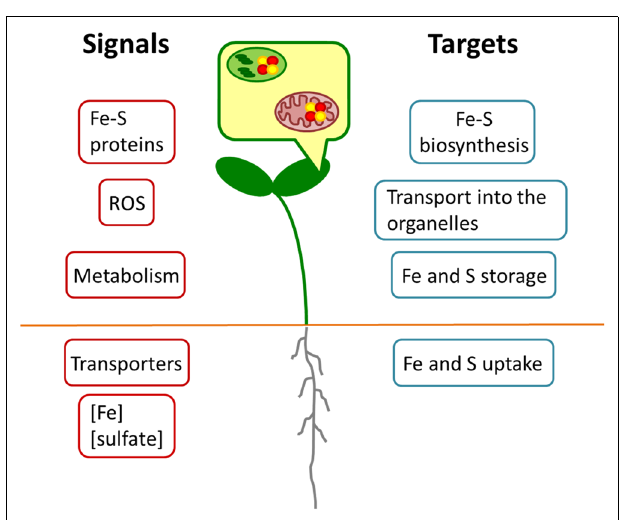
FIGURE 2 | Schematic model for regulatory interactions between Fe and S metabolism . Different putative Fe or S signals (red) may originate in the organelles or whole cells of root or shoot.Targets (blue) may comprise metabolic processes at expression or protein levels.